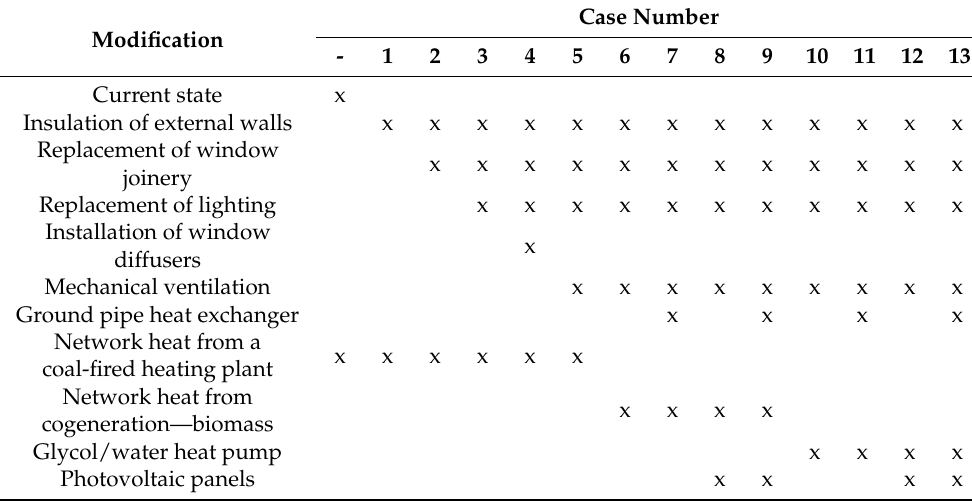
Table 2. Scenarios of energy-saving activities in the analyzed